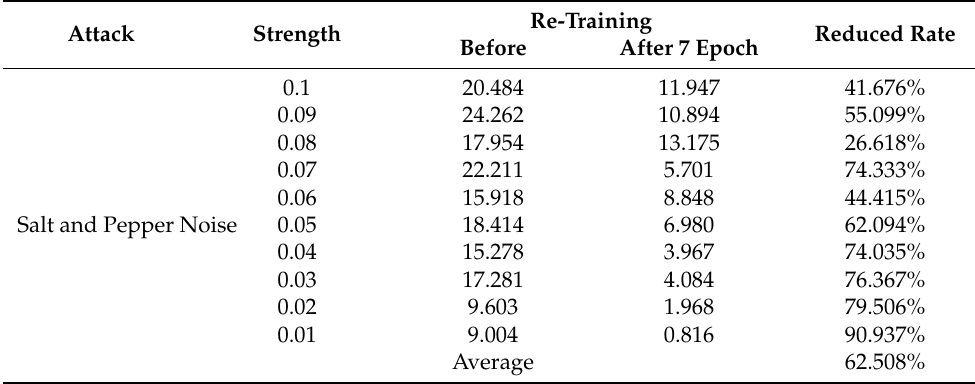
Table 5. Robustness comparison after re-training the proposed network for the attack (salt and pepper noise) with weak